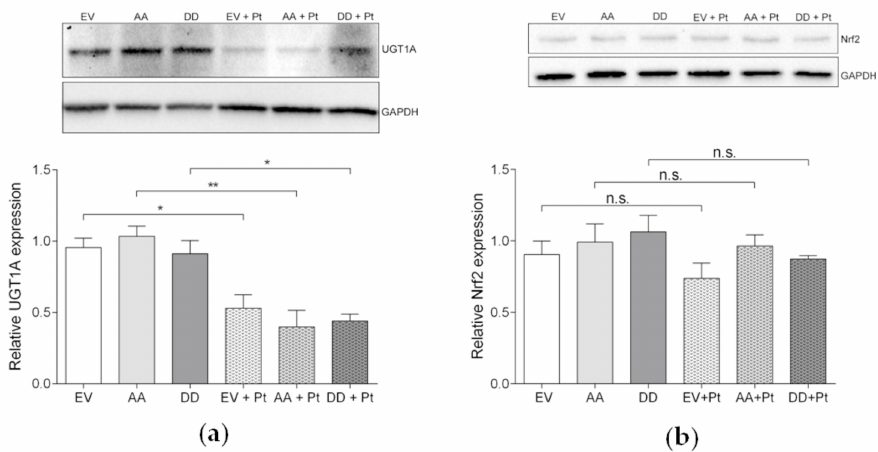
Figure 7. Representative Western blots and the corresponding densitometric quantification (mean ± SEM, n = 3) of ( a ) the relative uridine diphosphate-glucuronyl transferase (UGT)1A expression and ( b ) the relative nuclear factor erythroid 2-related factor 2 (Nrf2) expression in empty vector—(EV), PEA-15AA—(AA) and PEA-15DD-transfected—(DD) cells after treatment with 15 µ M cisplatin ( + Pt) for 24 h and in untreated transfected SKOV-3 cells. GAPDH was used as a loading control. * p < 0.05, ** p <